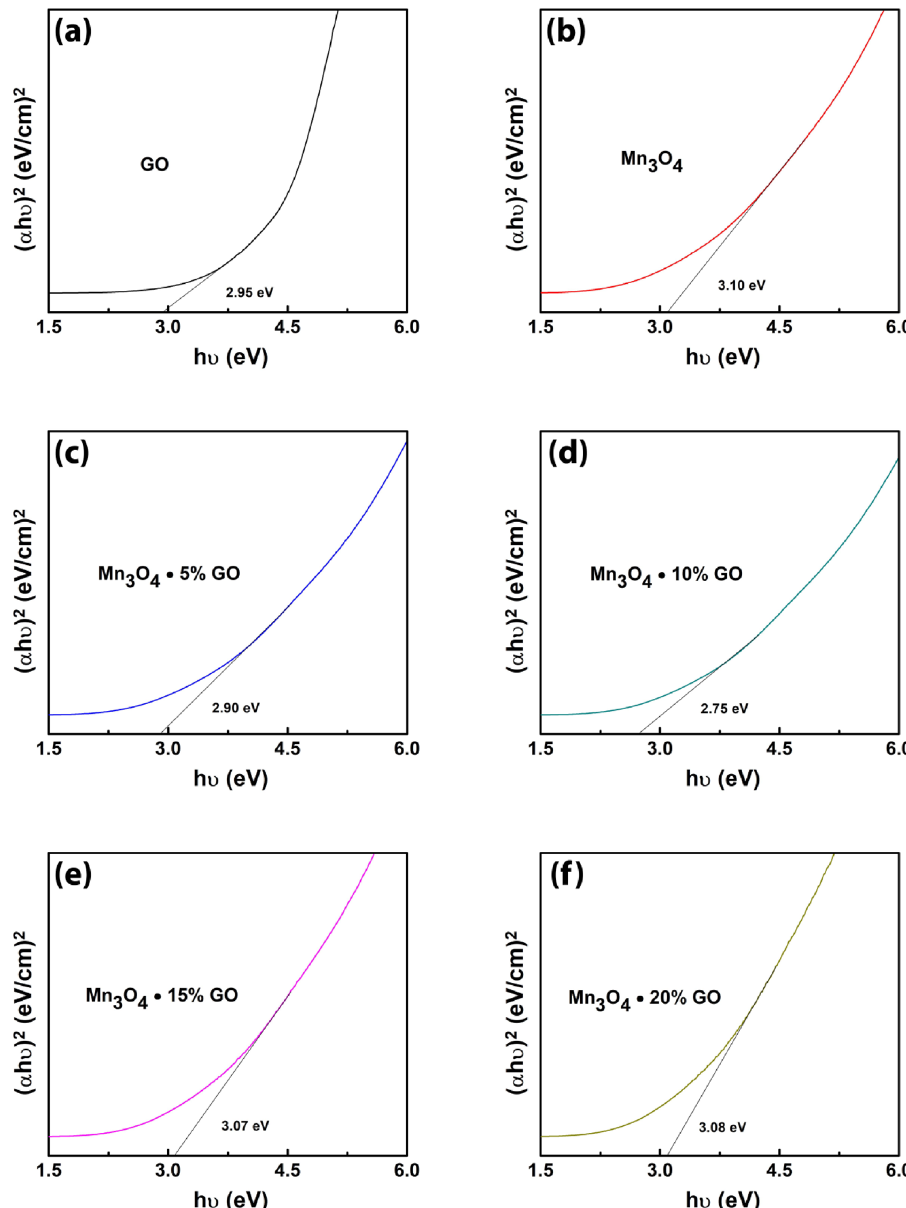
Fig. 9 Tauc’s plots of the absorption data for Go and the